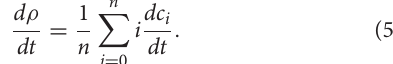
Frontiers in Physics |